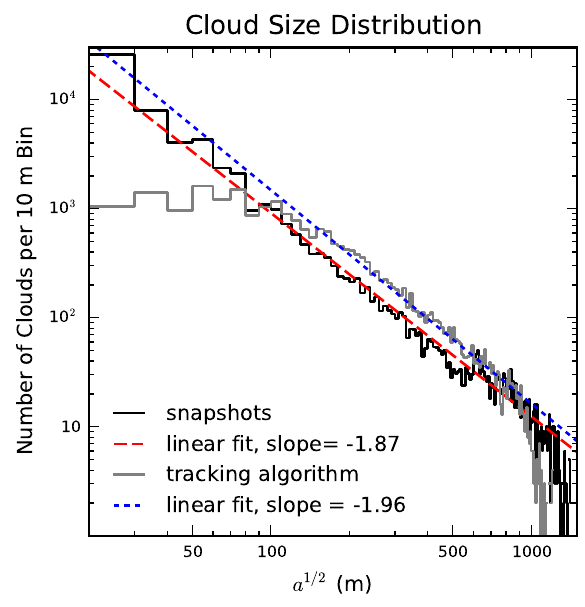
snapshots linear fit, slope= -1.87 tracking algorithm linear fit, slope = -1.96